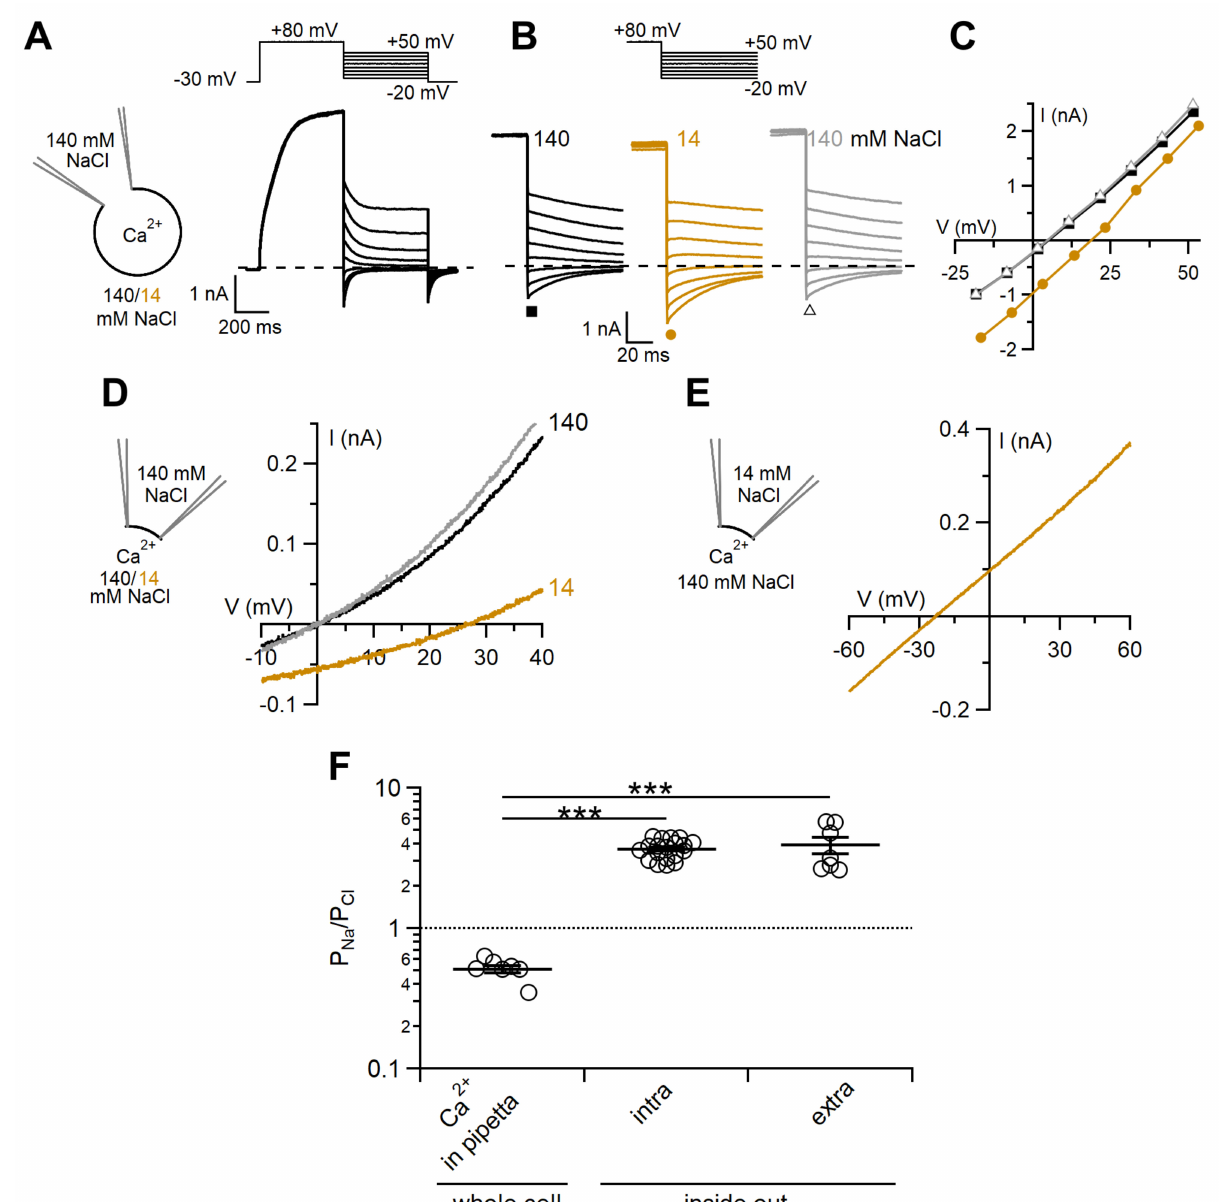
Figure 3. TMEM16F wt ion permeability ratio P Na /P Cl depends on the recording configuration. ( A , B ) Representative whole-cell voltage-clamp recordings obtained from representative TMEM16F wt-transfected cells with intracellular solution containing 50 µ M Ca 2+ . Voltage protocols are shown at the top of the panels. ( B ) A cell was first exposed to a control solution containing 140 mM NaCl, then to 14 mM NaCl and returned to 140 mM NaCl. ( C ) IV relations measured from tail currents of the cell shown on the left with 140 mM NaCl (squares), 14 mM NaCl (circles) and after returning to 140 mM NaCl (triangles). ( D , E ) Inside-out patches expressing TMEM16F wt were exposed to the indicated NaCl concentrations and the IV relations were determined by voltage ramps from +100 to − 80 mV. Only the regions around the reversal potentials are shown. Currents were activated by 100 µ M CaCl 2 and leakage currents measured in 0 Ca 2+ were subtracted. The pipette solution contained 140 mM NaCl (D) or 14 mM NaCl ( E ). ( F ) Comparison of P Na /P Cl calculated with the Goldman-Hodgkin-Katz equation from reversal potentials measured in different recording conditions (n = 7–19; *** p < 0.001 Tukey test after ANOVA, F = 48.256 p = 4.2 × 10 − 10